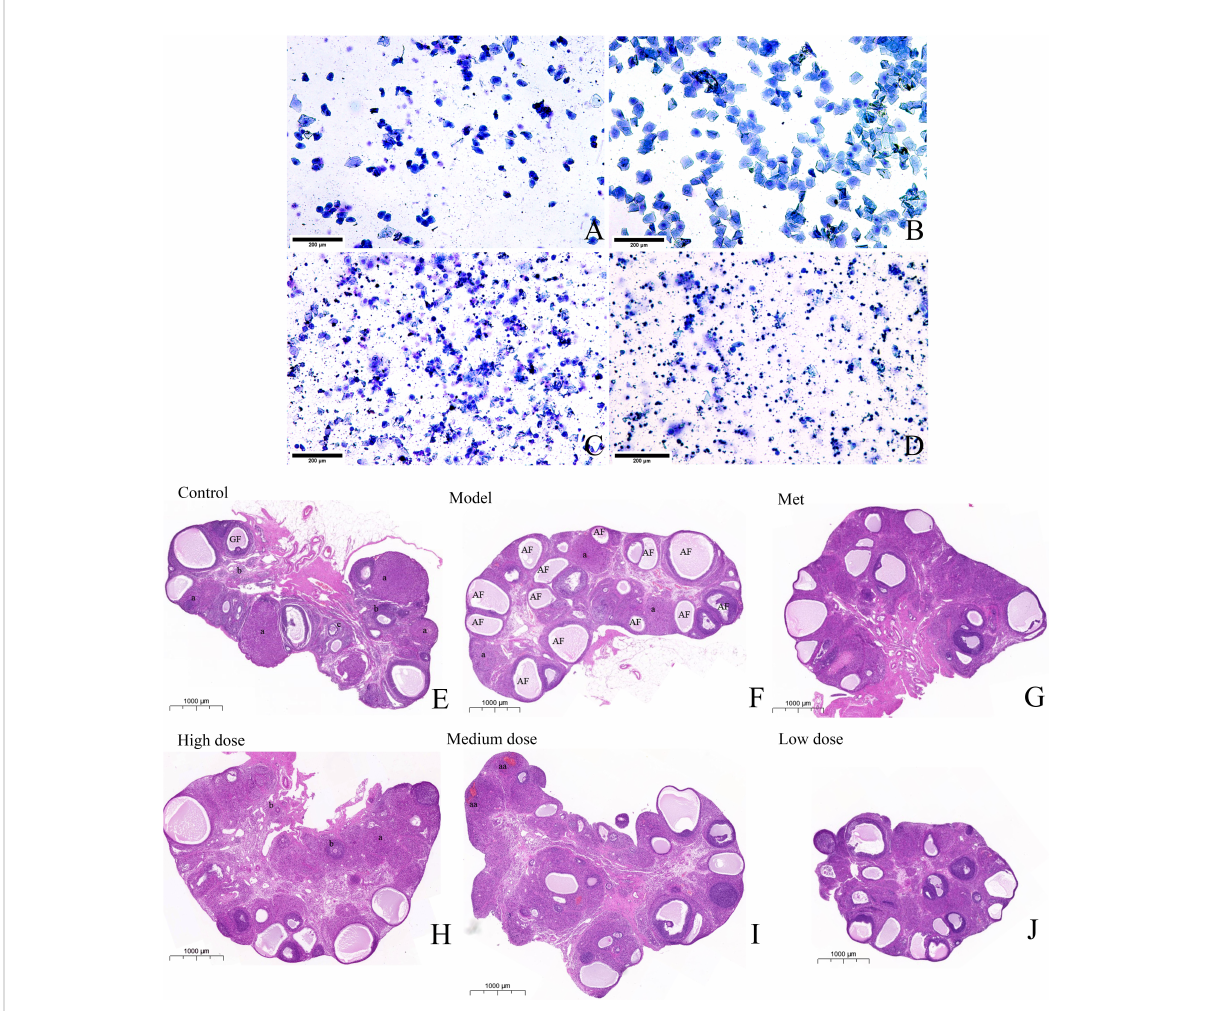
FIGURE 3 MCDD regulates PCOS-IR estrous cycle disorder and improves ovarian pathological characteristics. The vaginal smear method was used to observe the estrous cycle stages of the rats in each group under an upright microscope after methylene blue staining (A) Proestrus, (B) Estrus, (C) Metestrus, (D) Diestrus. The above results, n =12 (scan bar:200 m m). After the rats were sacri fi ced, the left ovaries were collected, soaked in 4% paraformaldehyde, representative images of H&E-stained rat ovaries for the indicated groups. (E) H&E-stained rat ovaries of control group (scan bar:1000 m m). GF (Gratian follicle), “ a ” means corpus luteum, ” b ” means Primordial follicle (PmF), “ c ” means Primary follicle (PrF). (F) H&E- stained rat ovaries of model group. AF (Atretic follicle). (G) H&E-stained rat ovaries of Met group. (H) H&E-stained rat ovaries of high dose